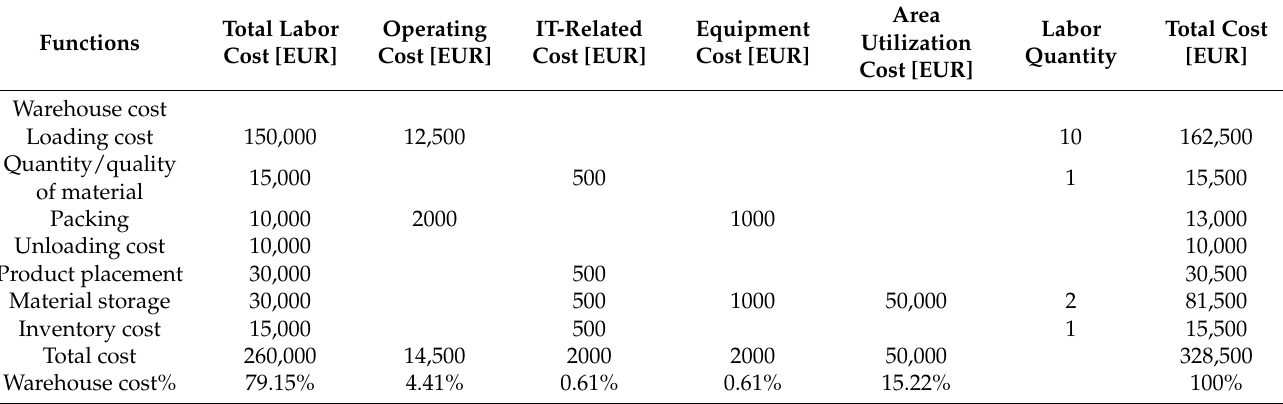
Table 3. Cost [EUR] needed for warehouse